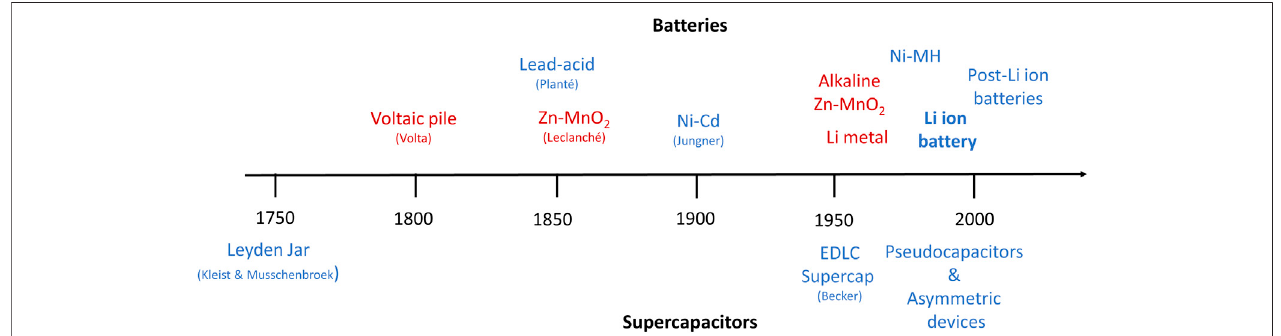
FIGURE 1 | A brief history of batteries and supercapacitors (red: primary, blue: rechargeable).